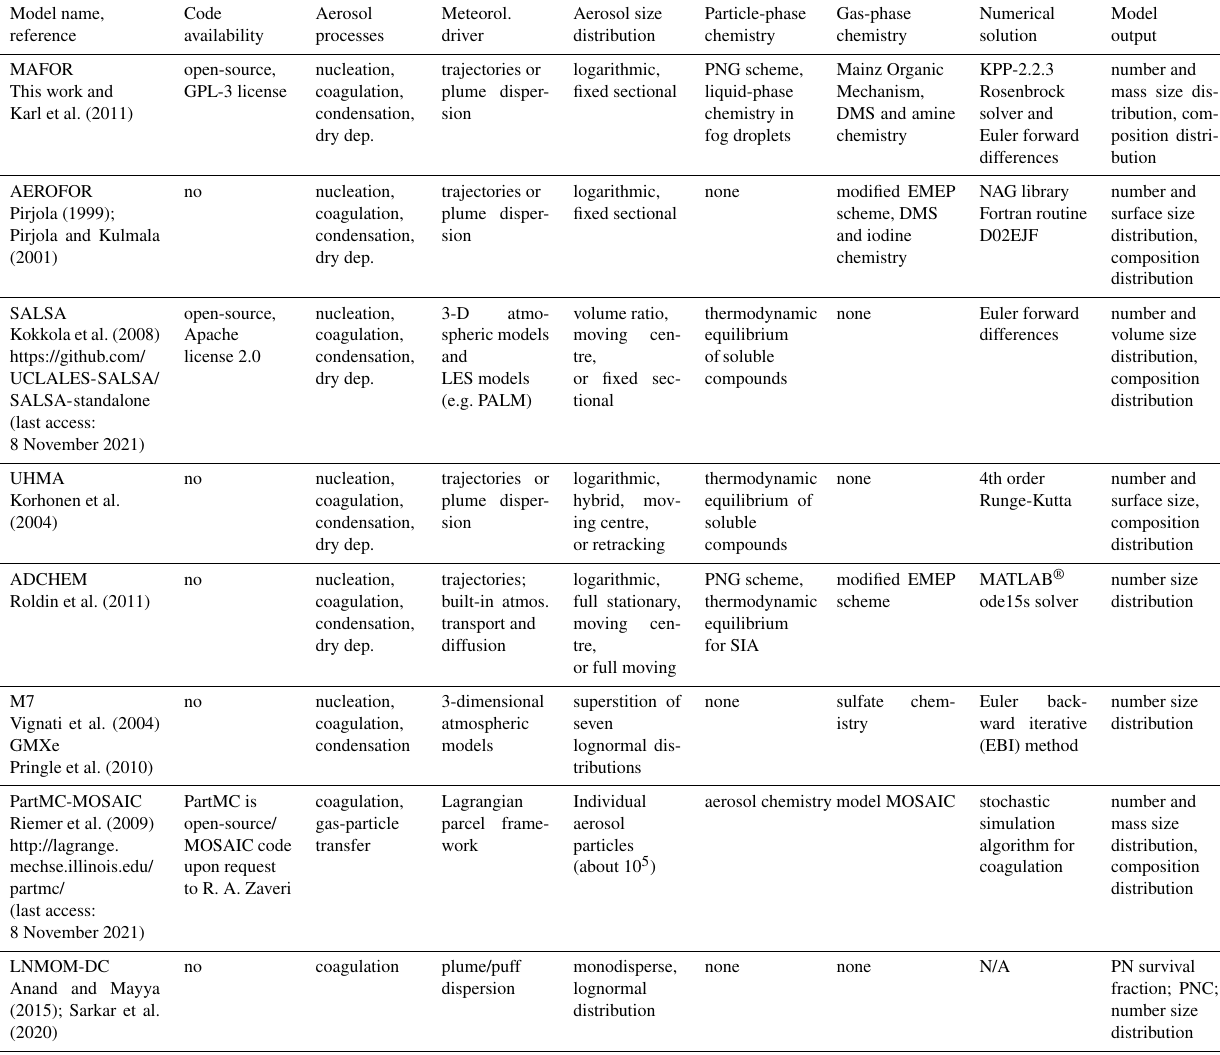
Table 1. Comparison of selected zero-dimensional aerosol dynamics models for atmospheric simulation